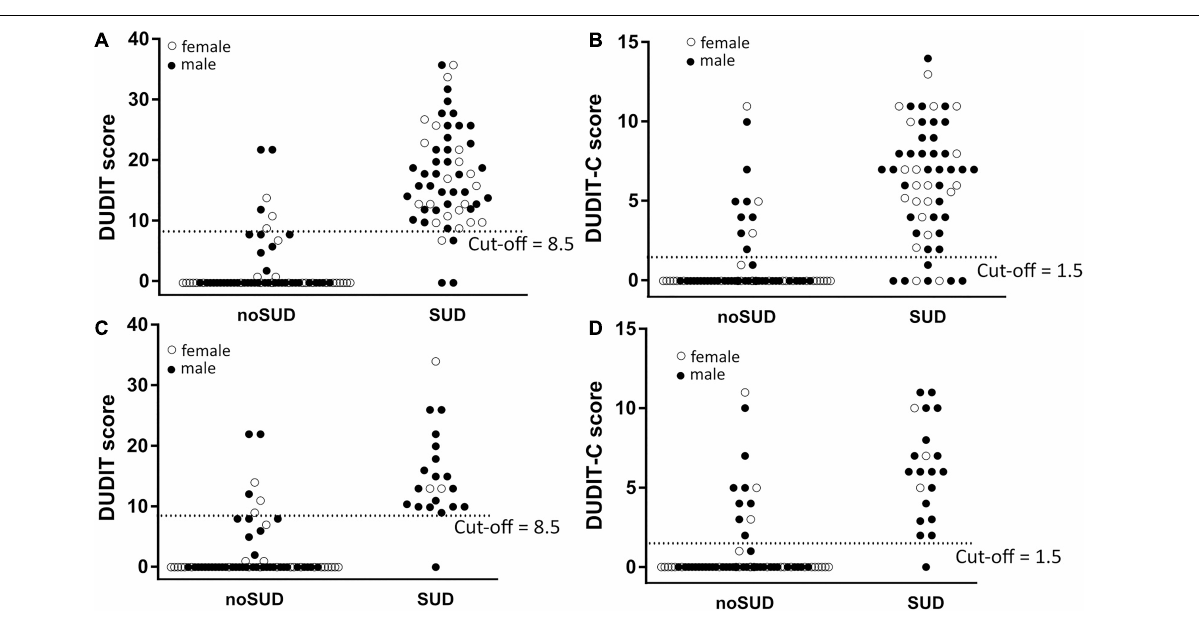
FIGURE 1 | Distribution of raw values of the DUDIT and DUDIT C. Single dots represent the results from a single participant. A dotted line marks the optimal cut-off score based on Youden’s Index J . (A) Raw values and cut-off for DUDT in total sample. (B) Raw values and cut-off for DUDIT-C in total sample. (C) Raw values and cut-off for DUDIT in mild and moderate cases. (D) Raw values and cut-off for DUDIT-C in mild and moderate